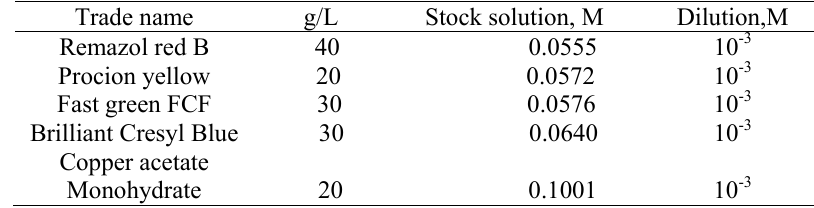
Table 2. The IR spectral data of dyes and their complexes (KBr, cm -1 )